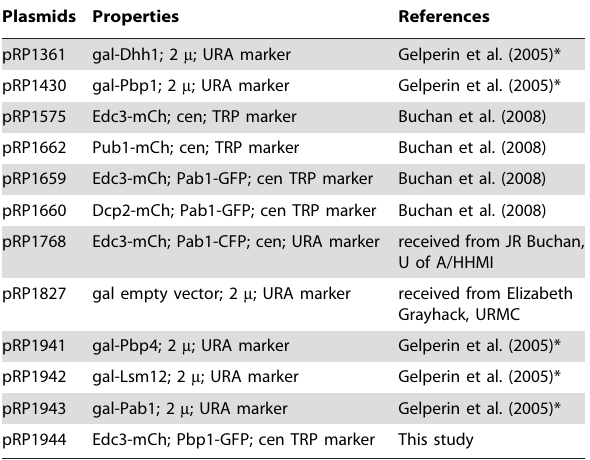
Table 2. Plasmids used in this